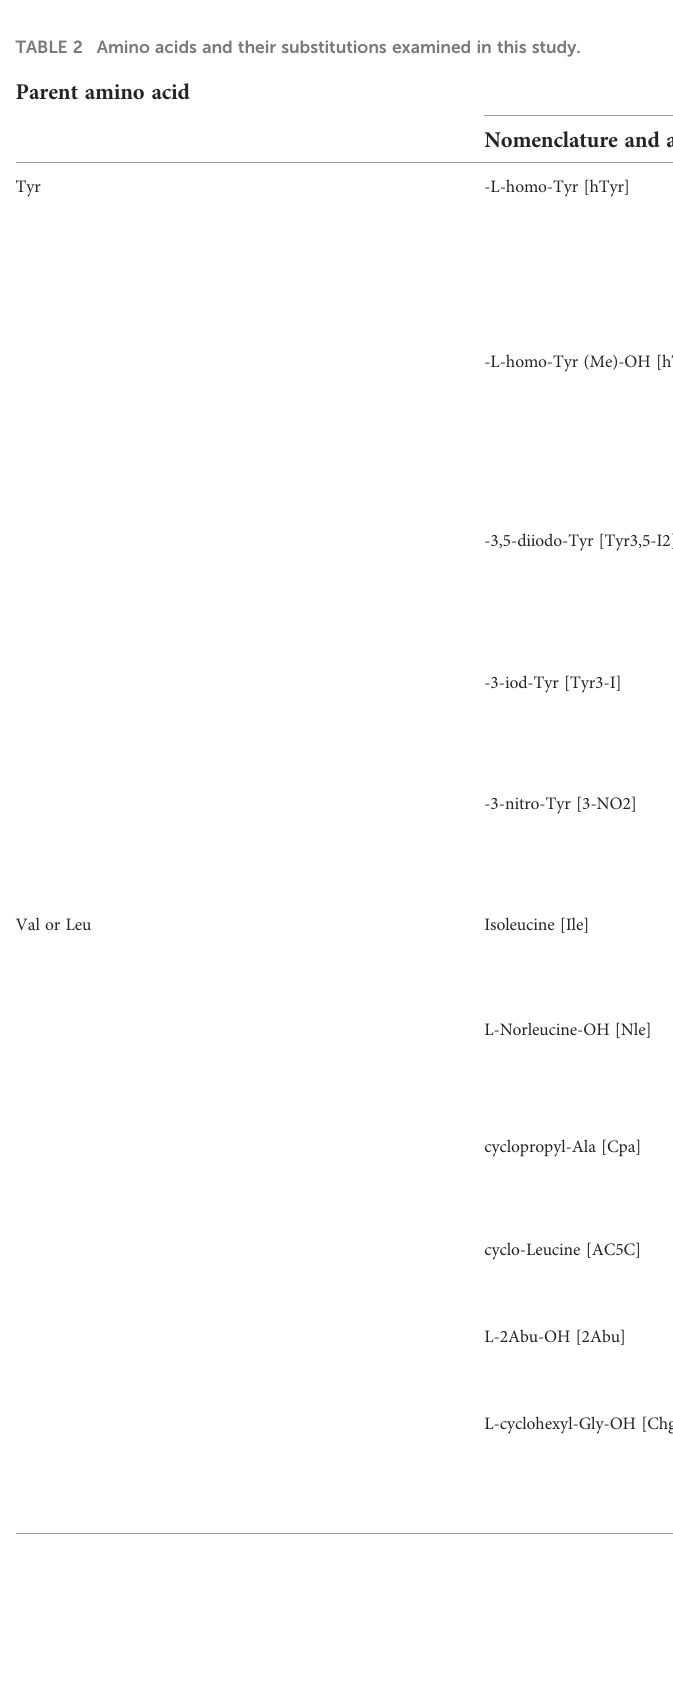
TABLE 2 Amino acids and their substitutions examined in this